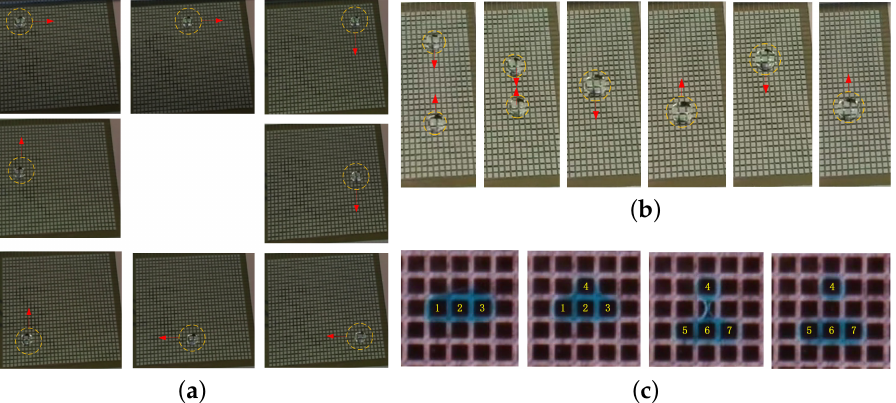
Figure 10. Video screenshots of the motion of droplets ( a ) moving along a loop path. ( b ) mixture of two droplets; ( c ) generation of a single droplet ( ∼ 0.1 µ